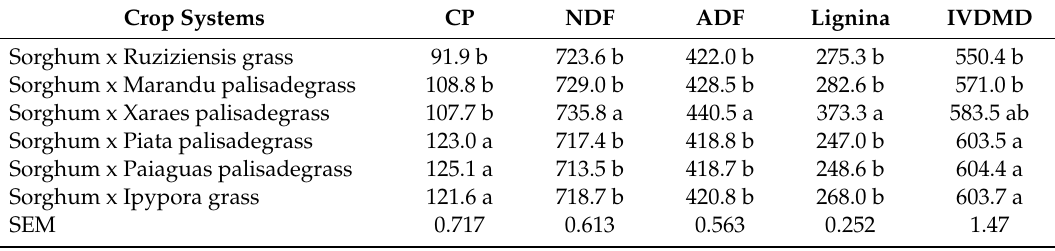
Table 5. CP, NDF, ADF, lignin, and IVDMD (g kg − 1 DM) contents of forages of the genus Brachiaria intercropped with grain sorghum, evaluated at harvest. Crop Systems CP NDF ADF Sorghum x Ruziziensis